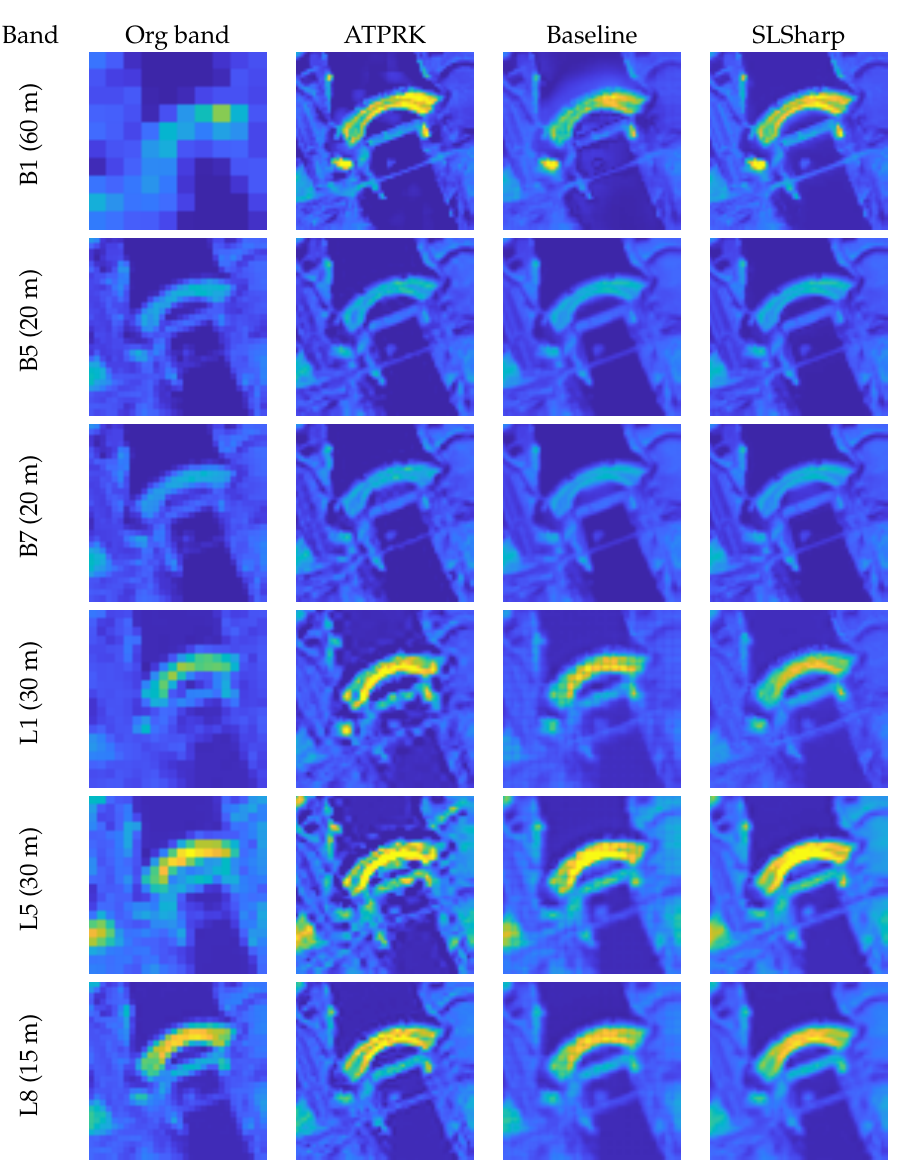
Figure 5. The results that were obtained by sharpening the Sentinel-2 bands 2, 5, and 7 and Landsat 8 bands 1, 5, and 8 of the AZ image. The original bands are in the leftmost column, the results from the ATPRK method are in the middle-left column, the results from the modified SupReME (baseline) method are in the middle-right column, and the results from SLSharp are in the rightmost column. A quantitative evaluation of the relative dimensionless global error (ERGAS), root mean square error (RMSE), spectral angle mapper (SAM) in degrees, signal-to-reconstruction error (SRE) in dB, structural similarity index measure (SSIM), and universal image quality index (UIQI) metrics was performed using the same images at reduced scales, with Wald’s protocol for the IS and AZ images as well as a synthesized image of Escondido [40–42]. The images were first reduced by 2 × and 6 × . Bayesian optimization was then used to find